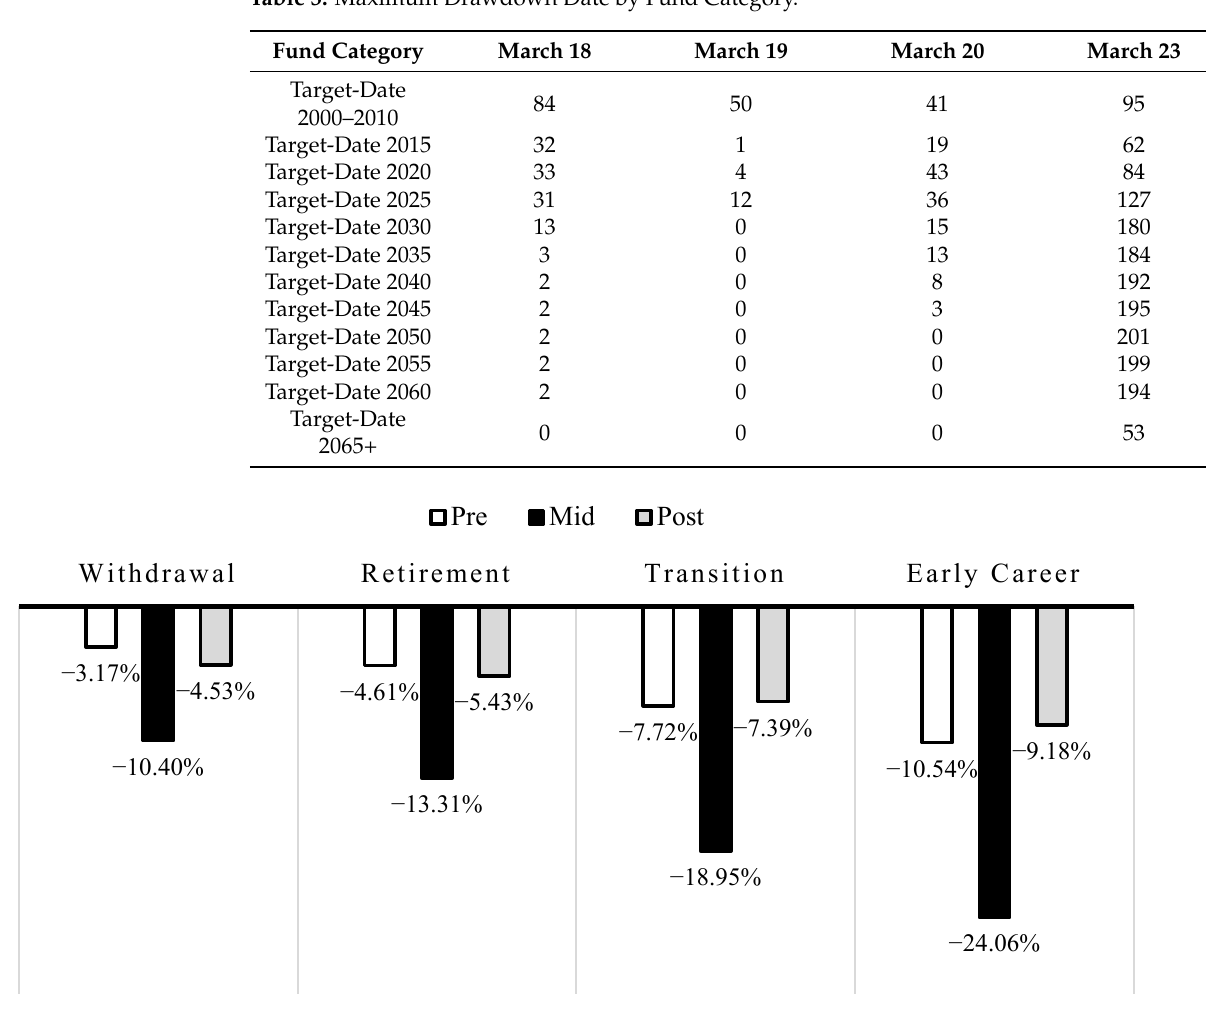
Table 3. Maximum Drawdown Date by Fund Category.